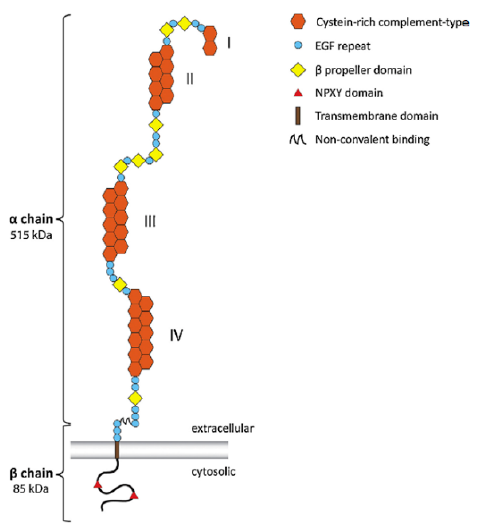
Figure 2 . Structure of lipoprotein receptor-related protein 1 (LRP1) [38]. Figure 2. Structure of lipoprotein receptor-related protein 1 (LRP1)